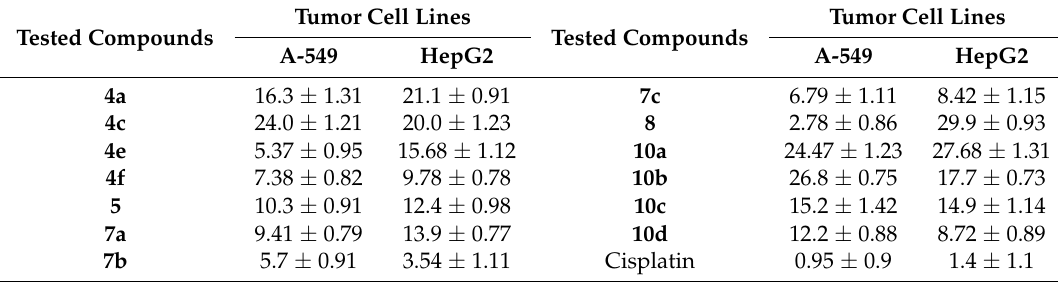
Table 1. The in vitro inhibitory activity of tested compounds against tumor cell lines expressed as IC 50 values ( μ g/mL) ± standard deviation from three replicates.